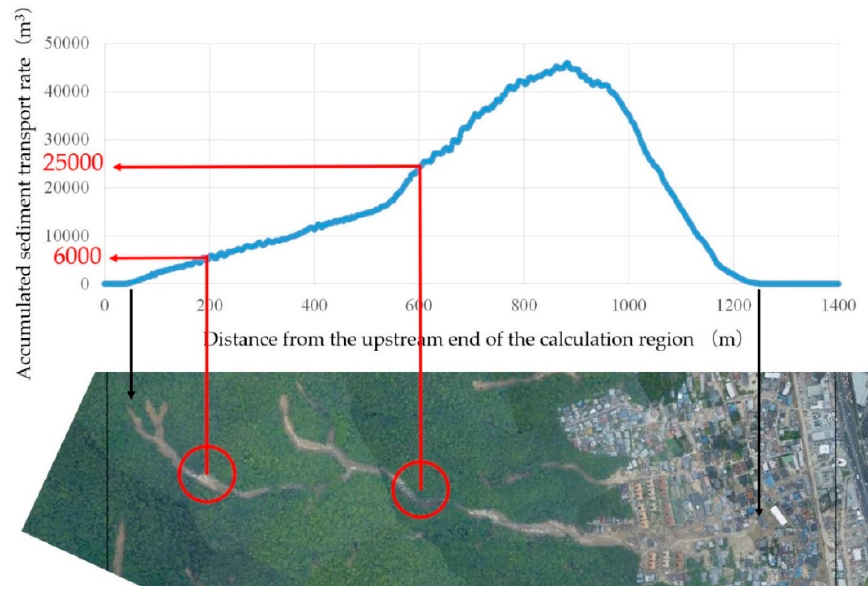
Figure 18. Longitudinal distribution of the temporally accumulated sediment transport rate through the calculation.